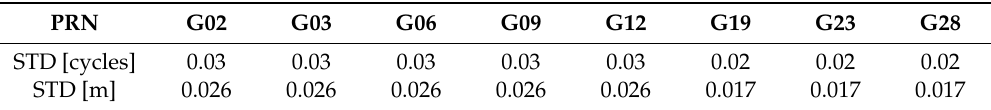
Figure 5. Wide-lane uncalibrated phase delay of the GPS satellite between the 187th and the 206th day of 2016. Table 1. Wide-lane uncalibrated phase delay STD of the GPS satellite between the 187th and the 206th day of 2016.